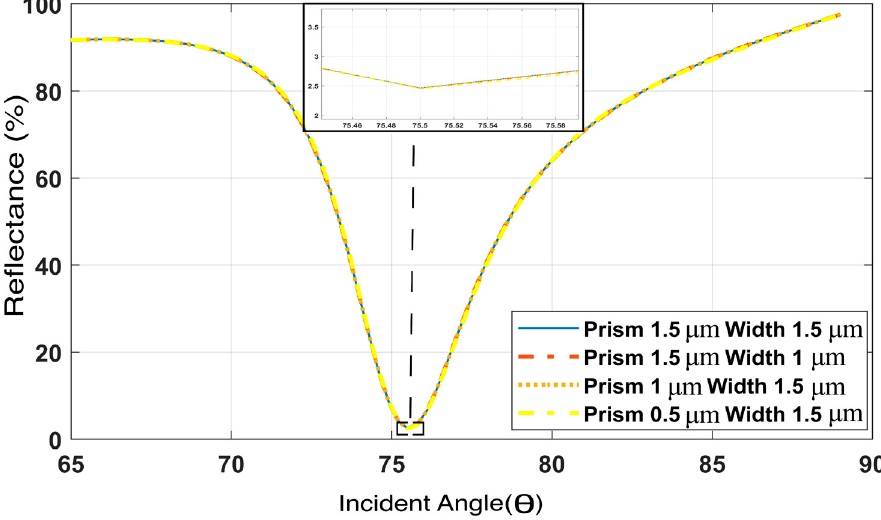
Figure 4. Effect of the height of the prism layer and the total width on the proposed sensor.